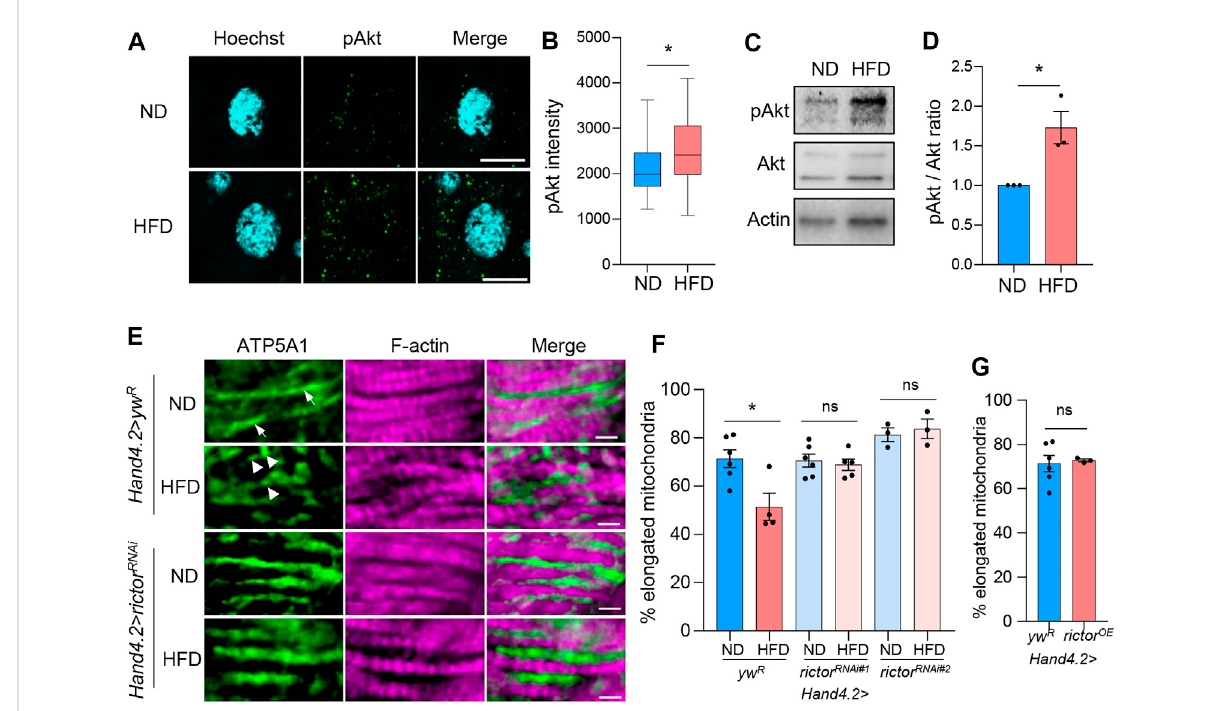
FIGURE 1 mTORC2 regulates HFD-induced mitochondrial fi ssion in Drosophila hearts. (A) Immunostaining of phospho-Akt in fl y cardiomyocytes after 2 days of ND or HFD treatment. Scale bar: 10 μ m. (B) The quanti fi cation of mean fl uorescence intensity of the phospho-Akt. Student ’ s t-test (* p < 0.05). N = 10 (10 hearts per diet, 2 cardiomyocytes per heart). (C) Western blot analysis of the pAkt, Akt and beta-actin in fl y hearts. (D) The quanti fi cationofbandintensityofthephospho-AktnormalizedtototalAkt.Student ’ st-test(* p < 0.05).N=3(3replicatesperdiet,20heartsper replicate). (E) Immunostaining of mitochondria and F-actin of cardiomyocytes from ND- or HFD-treated control ( yw R ) and rictor knockdown fl ies. The cardiac driver Hand4.2-Gal4 is used to drive heart-speci fi c knockdown. Mitochondria are visualized using an anti-ATP5A1 antibody. Scale bar: 10 μ m.Arrows:elongatedmitochondria.Arrowheads:fragmentedmitochondria. (F) Theproportionoftheelongatedmitochondriawithamaximum diameter greater than 2 μ m in ND- or HFD-treated control and rictor knockdown fl ies. Two-way ANOVA: Interaction between diet and genotype